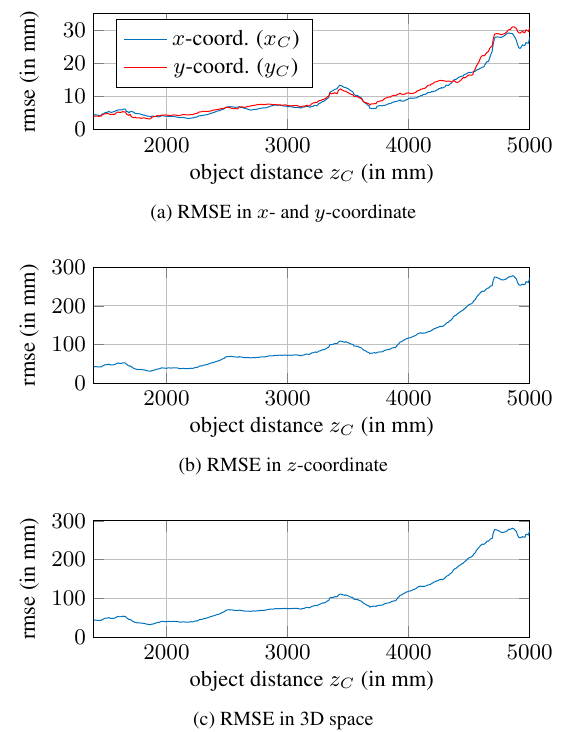
Figure 8. RMSE of feature points projected back to 3D object space.